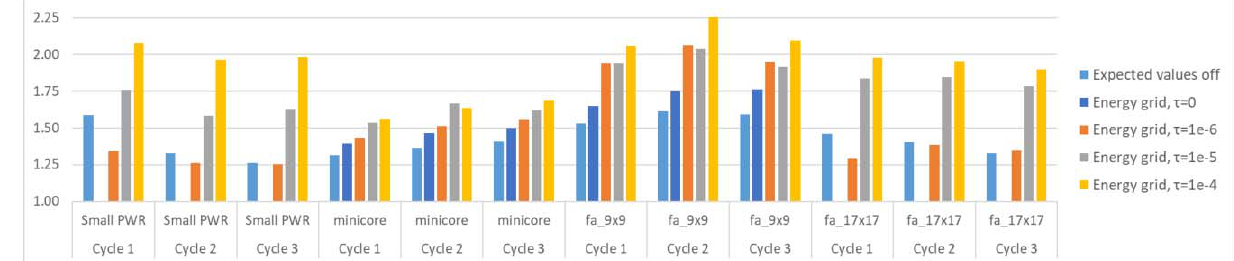
Figure 3. Speedup of burnup calculations